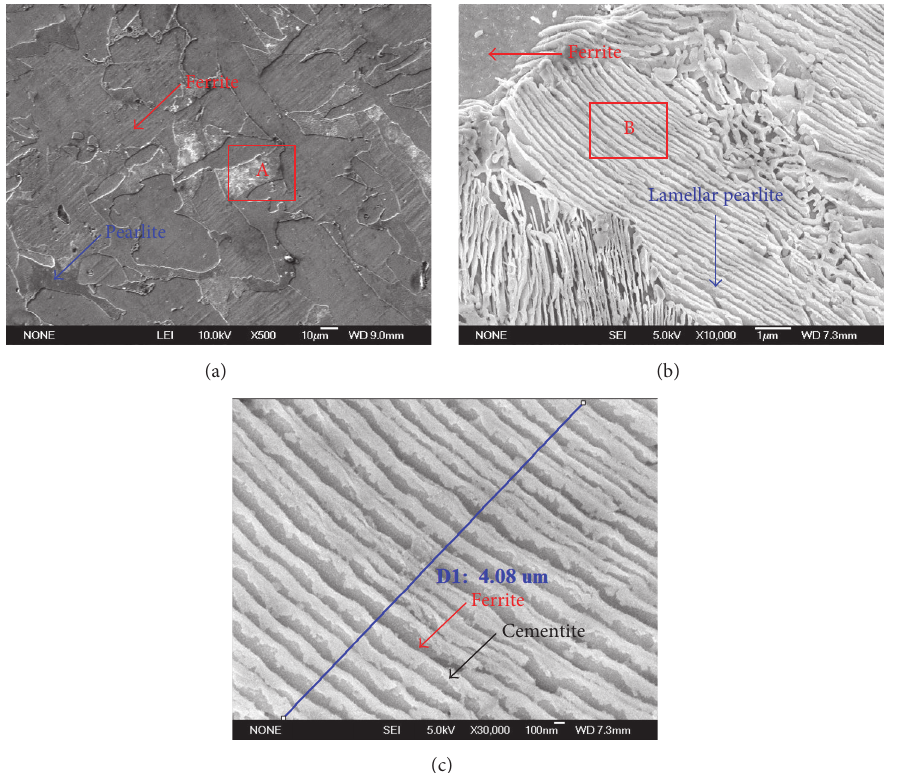
Figure 3: Typical FE-SEM micrographs of the 1045 carbon steel after annealing at 873 K (600 ∘ C) for 2h ((b) is the higher magnification of the A region in (a); (c) is the higher magnification of the 𝐵 region in